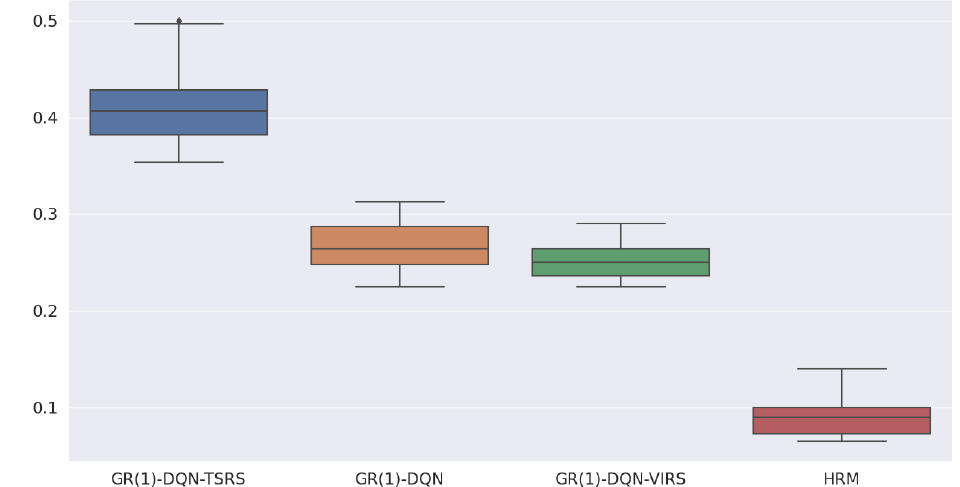
Figure 9. Box plot of learning curve for ϕ 2 under the same environment.